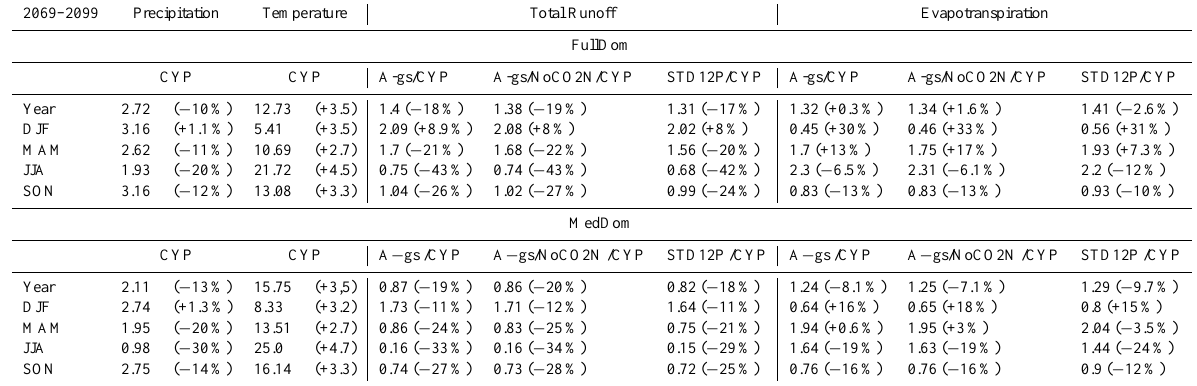
Table 3. Same as Table 2 but for the end of the 21st century and the corresponding anomalies with 1970–2000. A-gs/NoCO2N/CYP corresponds to the ISBA-A-gs version with the CYPRIM scenario and no CO 2 effect.